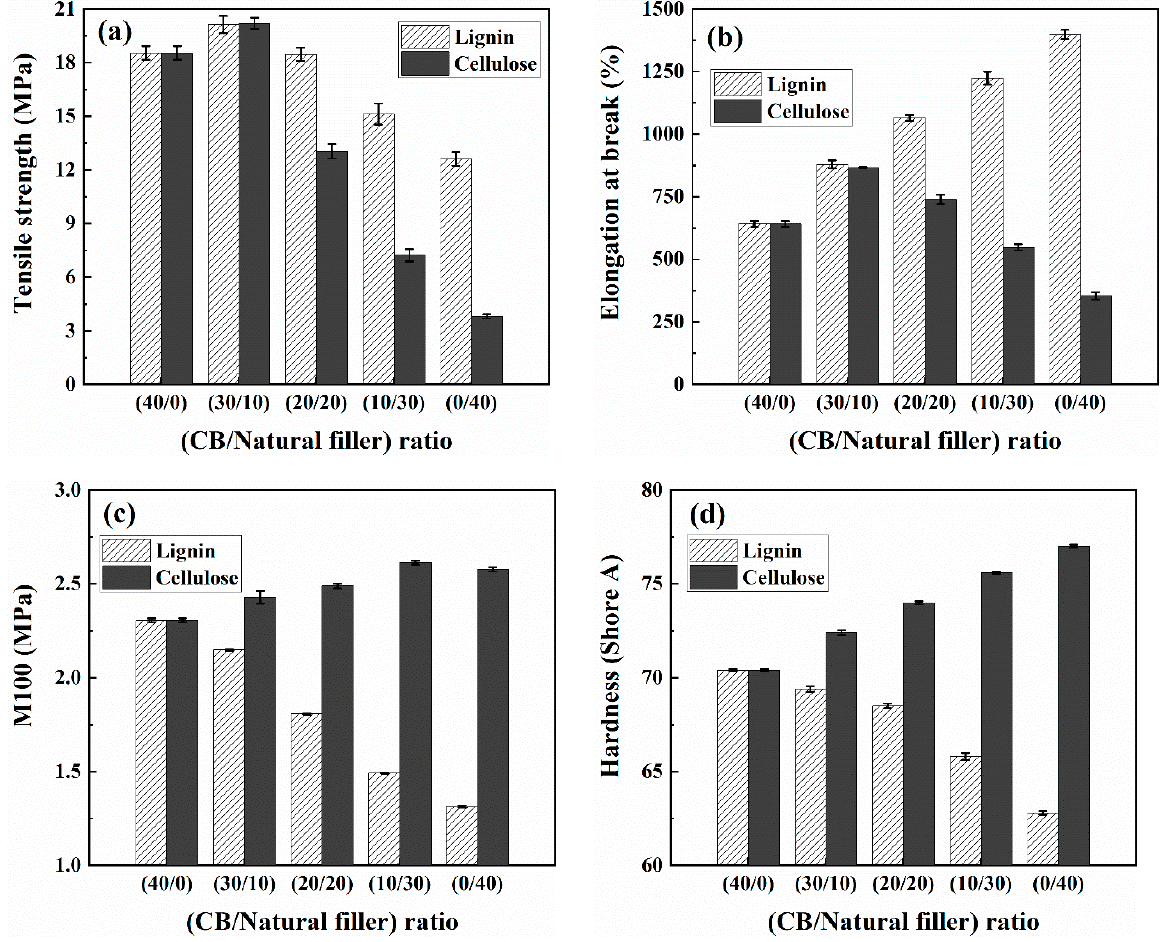
Figure 10. Mechanical properties of NR composites filled with cellulose and lignin at different concentrations: ( a ) tensile strength, ( b ) elongation at break, ( c ) modulus at 100% elongation and ( d ) hardness (reproduced with permission from [106]).